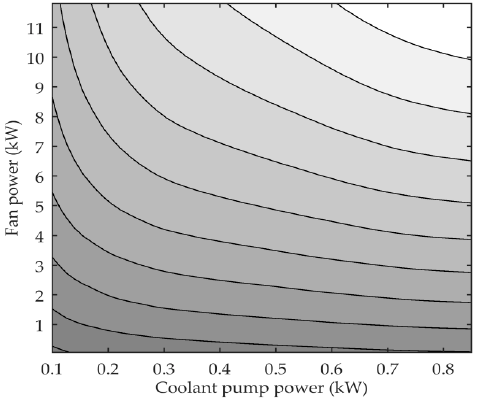
Figure 7. Radiator performance .